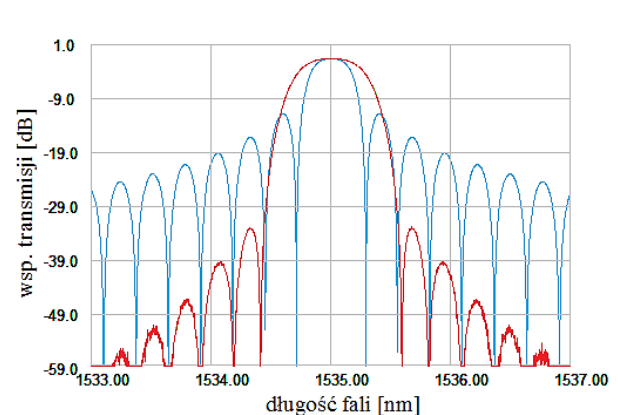
Fig. 11. Comparison of Bragg fiber gratings spectral characteristics without apodization – blue line and apodized cosine function for wsp. А = 2 – red line.